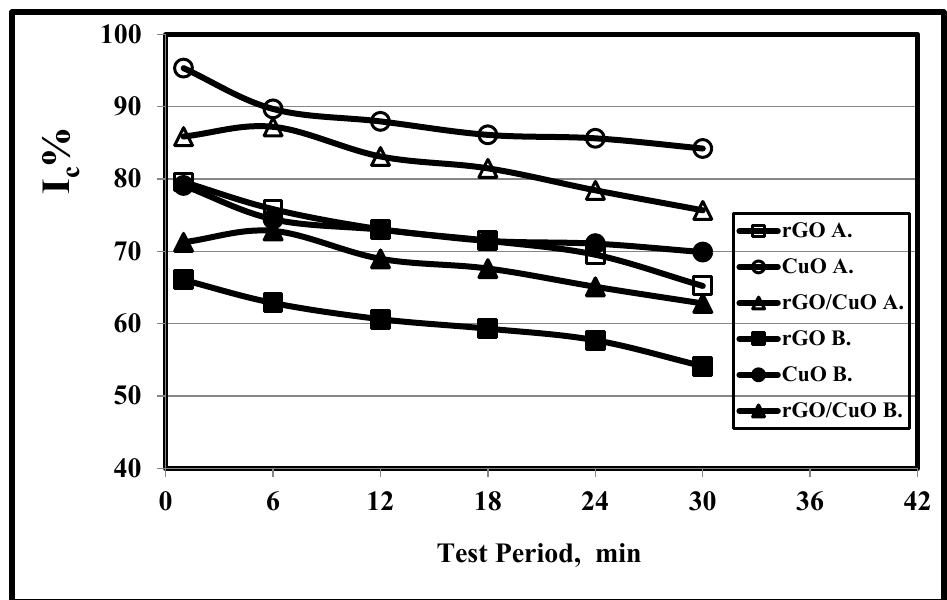
Figure 4. Effect of test period on the on the crystallinity index values of rGO, CuO, and 1.0 wt.% rGO/CuO, using both methods A and B at 20 °C.